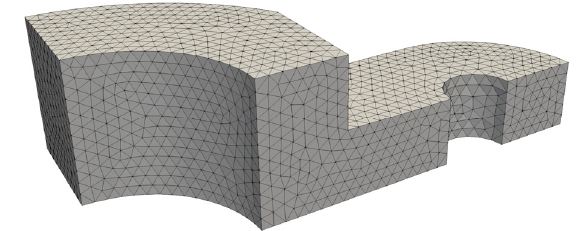
Figure 4. Finite element mesh of one quarter of the specimen used for numerical simulations 4.